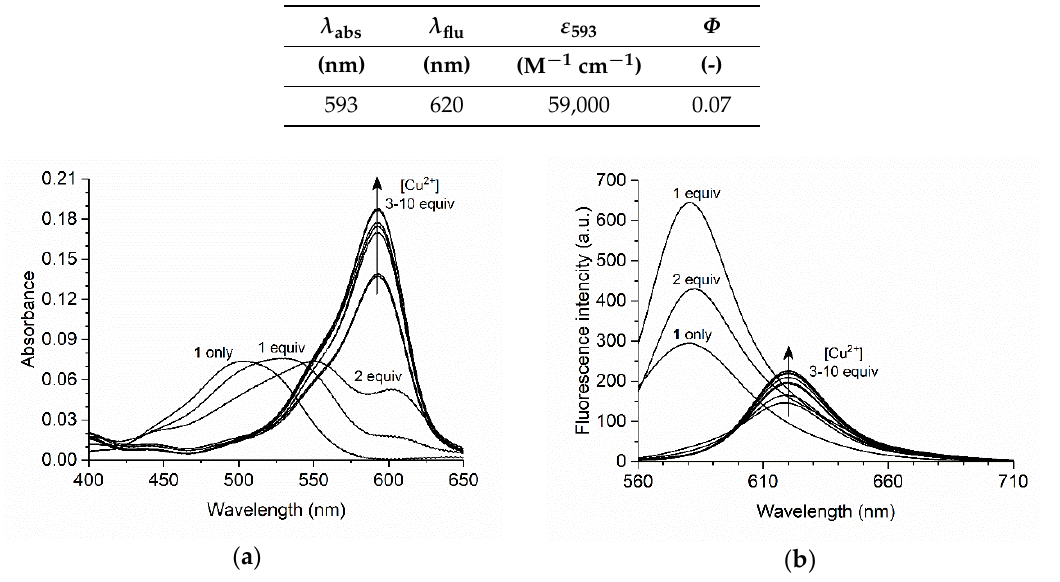
Table 2. Photophysical properties of BODIPY 1 with Cu 2+ (10 equiv) in acetonitrile.